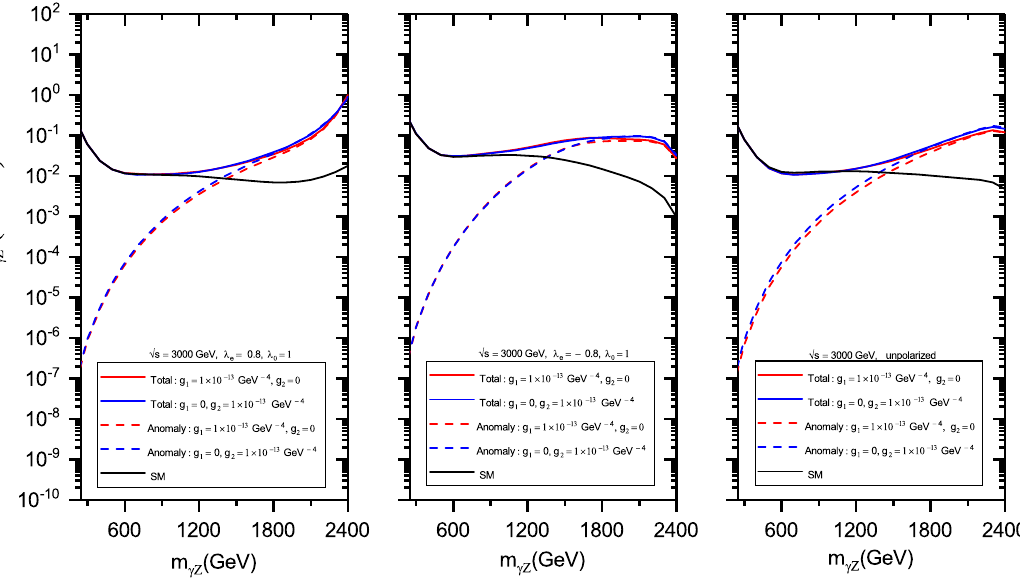
√ s = 3000 GeV, and coupling